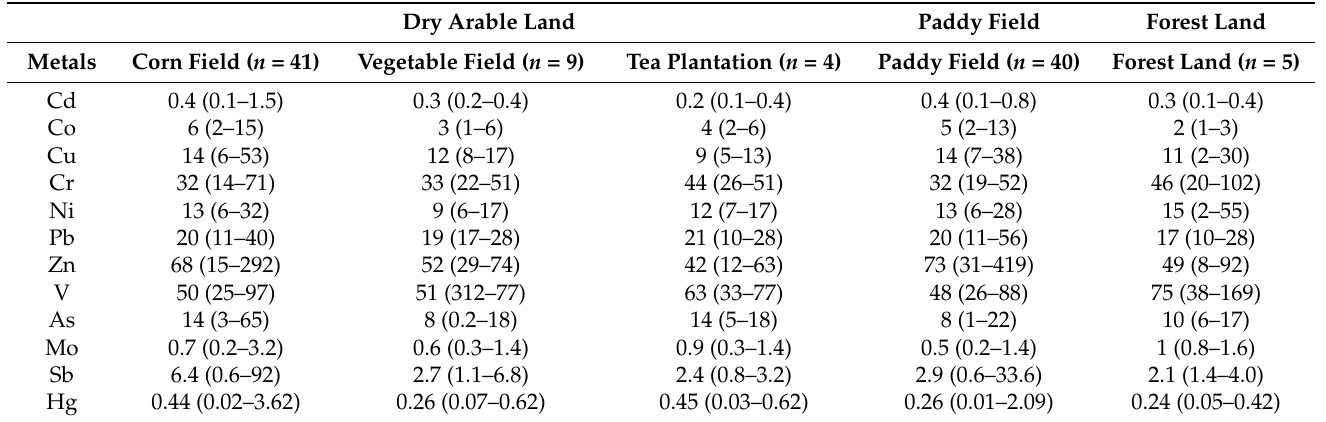
Table 2. The PTE contents in soils from different types of land in the Caidi Watershed (mg/kg). Dry Arable Land Paddy Field Forest